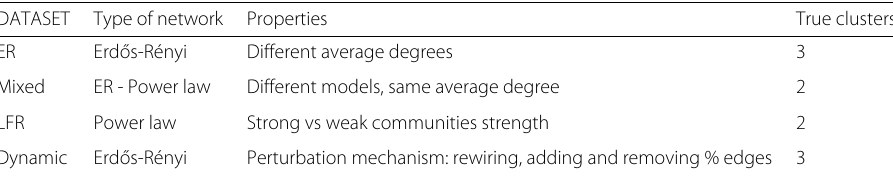
Table 1 Summary of synthetic datasets DATASET Type of network